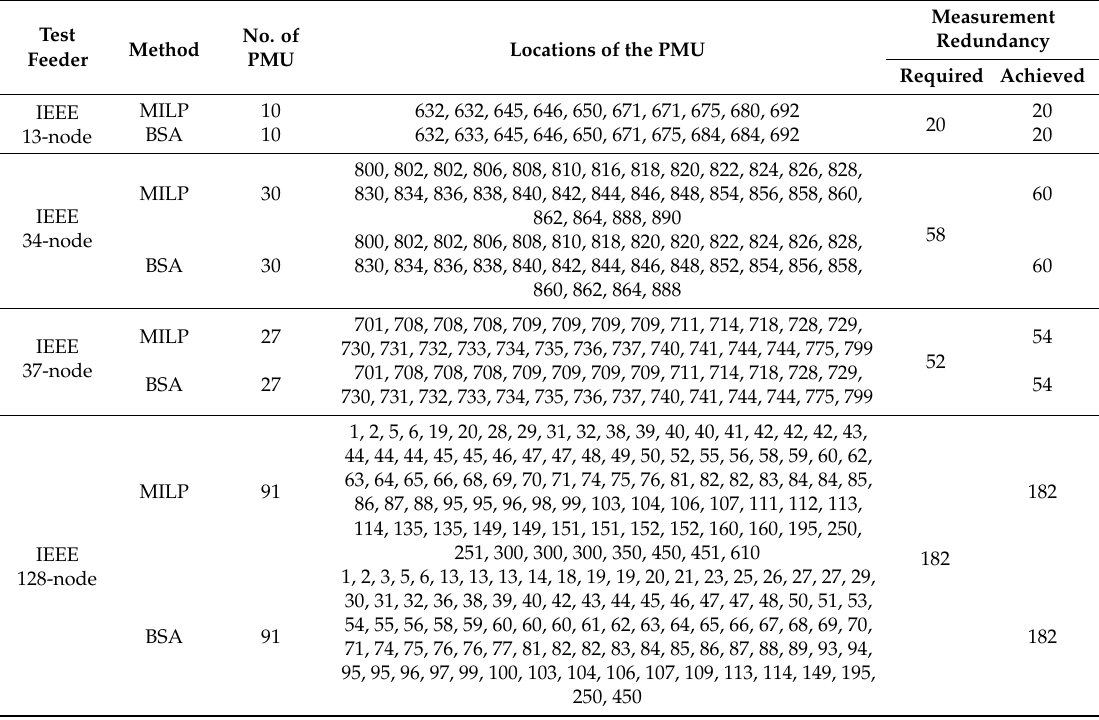
Table 9. Optimal numbers and locations of PMU considering ZIB and a single channel for each PMU during a single PMU loss